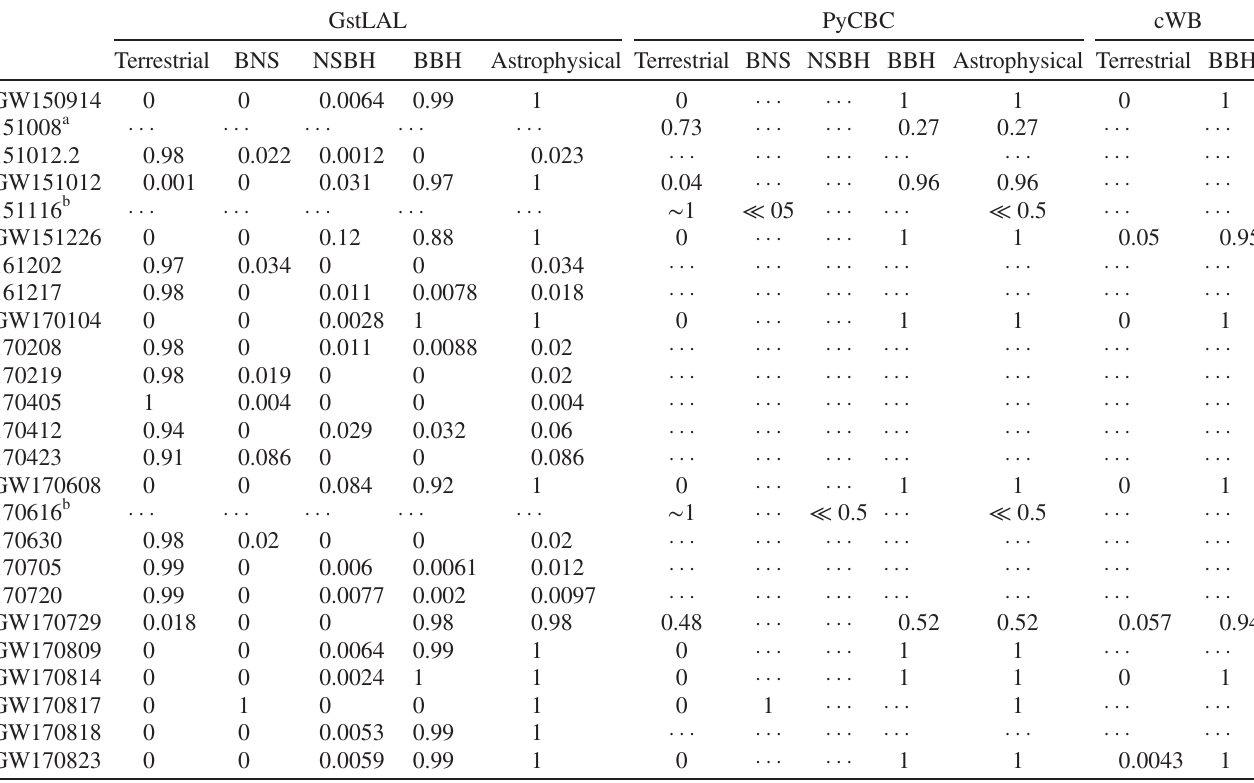
TABLE IV. This table lists the probability of each event candidate belonging to a given source category. Each category is further delineated by the probabilities derived from each search pipeline ’ s output. Where candidate values are not indicated, the search did not calculate a probability for that category or did not have a candidate with a ranking statistic sufficient for interest. p A are shown as zero. The astrophysical category is the sum over the BNS, NSBH, and BBH categories (where available), and the sum over astrophysical and terrestrial is